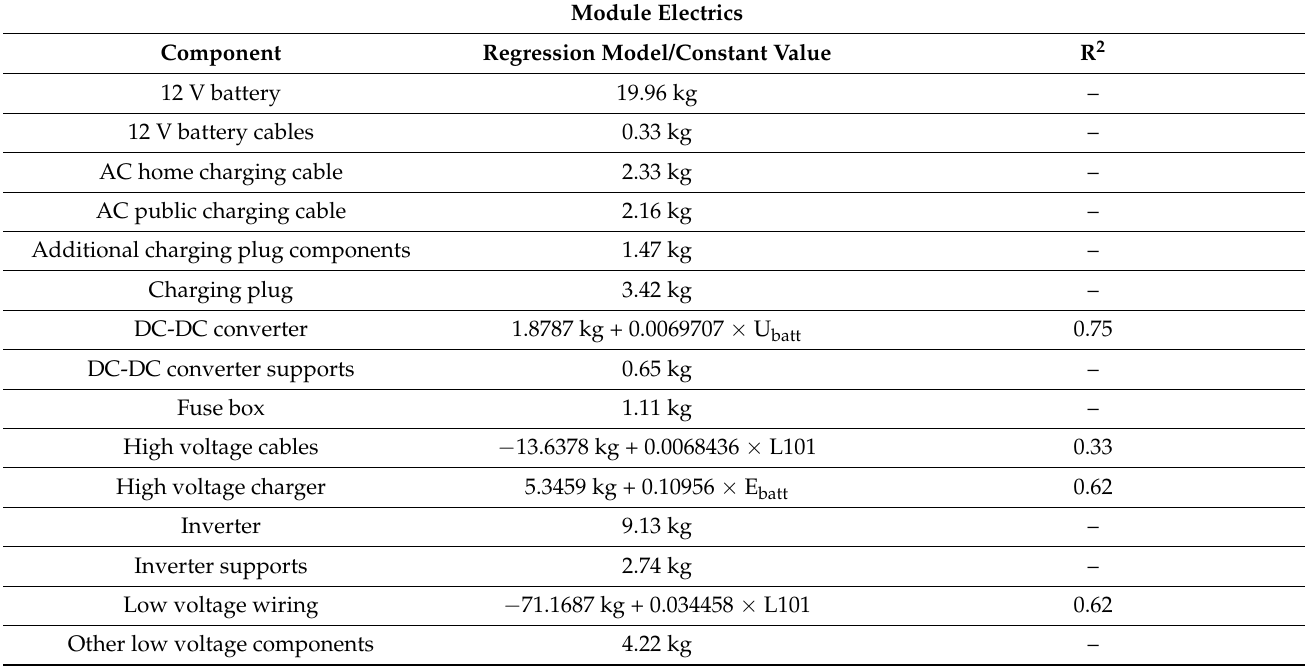
Table A8. Empirical models for the Electrics module.